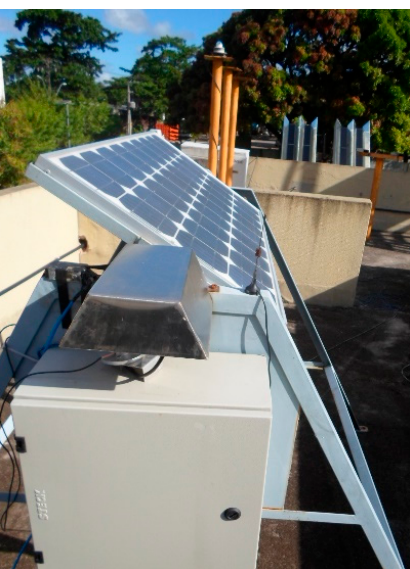
Figure 1. The polar mount multitracking design.